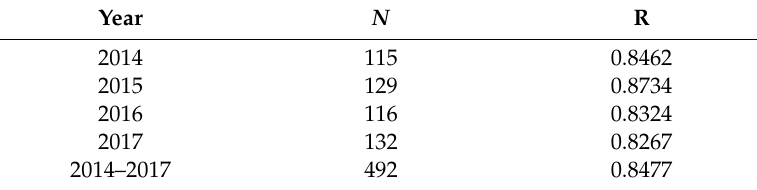
Table A3. Pearson correlations between AERONET AOD values at times when two satellites overpass.